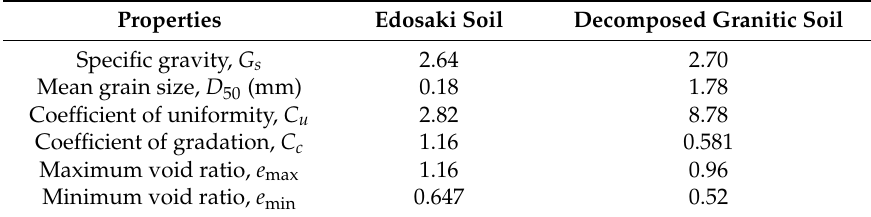
Table 1. Physical properties of Edosaki and decomposed granitic